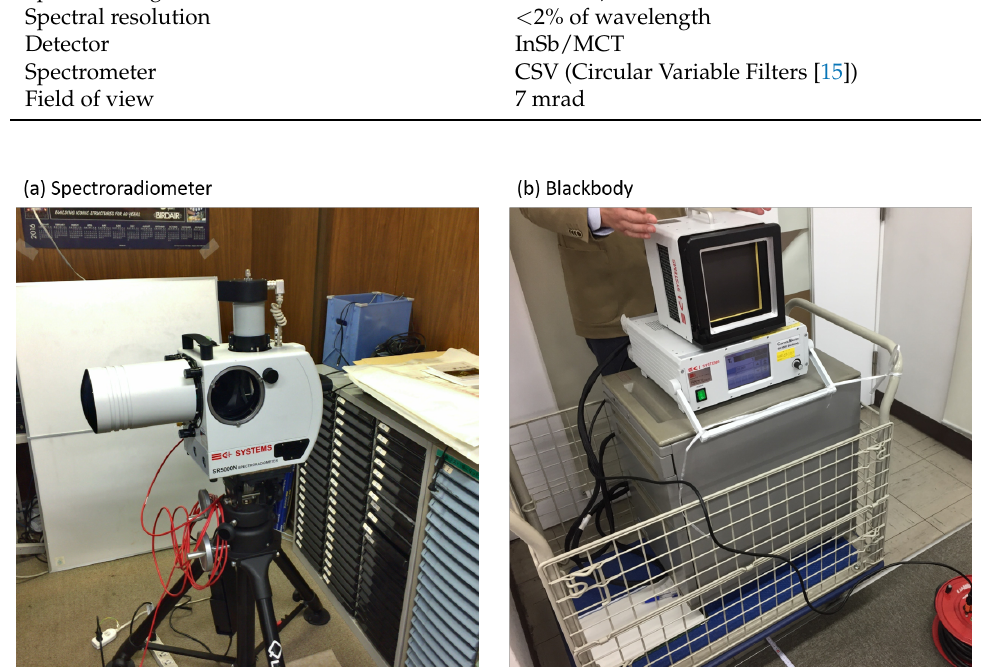
Figure 4. ( a ) Spectroradiometer (SR-5000N, CI-Systems, USA [31]). ( b ) Blackbody (SR-800N CI- Systems, USA